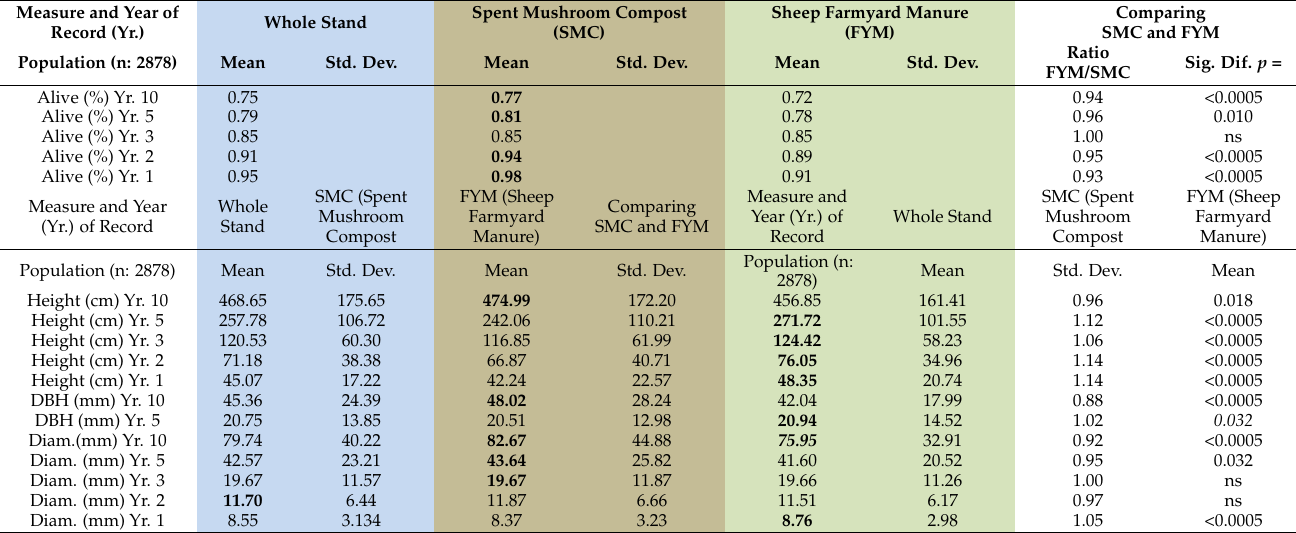
Table 3. Survival and tree growth for the whole (Sy96) stand (blue) and also SMC (mushroom) vs. FYM (green). The numbers are the correlation coefficient (bold where significant). Measure and Year of Record